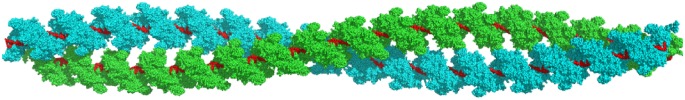
View of one turn of a RecA negatively supercoiled filament at atomic resolution.The structure has been constructed following the geometric characteristics described by Shi and collaborators [18], with a pitch P = 160 nm for the the supercoil (see text and S1 Protocol, supporting information). The axis of the two strands (in cyan and green, respectively) are separated by 110 Å. The DNA incorporated in each of the two RecA filaments is in red.